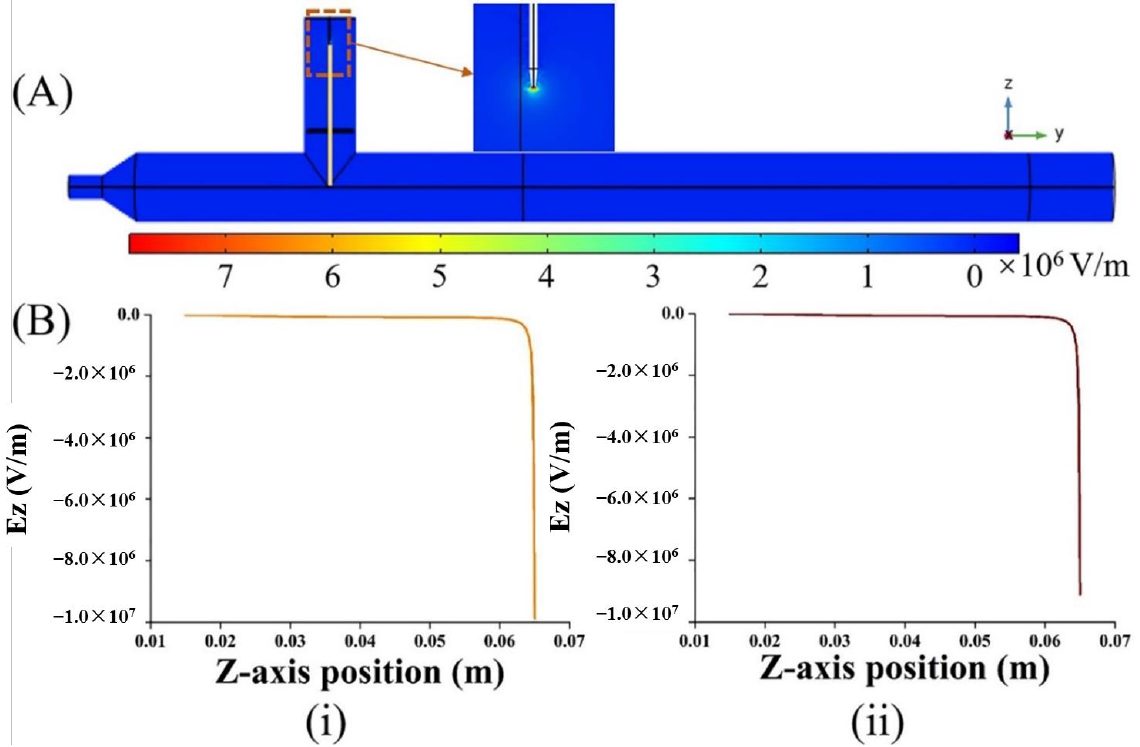
Figure 6. ( A ) Contour of Z-component of electric field strength. ( B ) Distribution of Ez along vertical direction below the nozzle with different applied voltages on the nozzle and ring electrode: (i) nozzle voltage of 6000 V and grounded ring; (ii) nozzle voltage of 7000 V and ring voltage of 500 V.